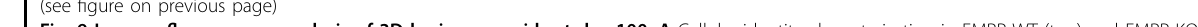
Fig. 9 Immuno fl uorescence analysis of 3D brain organoids at day 100. A Cellular identity characterization in FMRP-WT (top) and FMRP-KO (bottom) brain organoids. Immunostaining at day 100 revealed the presence of cells positive for pan-neuronal marker MAP2 (red) and GFAP expressing astrocytes (green). Nuclei were stained with DAPI (blue). Scale bar: 500 μ m. B Higher magni fi cation of representative GFAP-positive regions within FMRP-WT (top) and FMRP-KO (bottom) brain organoids at day 100. Scale bar: 20 μ m. C Bar charts showing the fl uorescence intensity quanti fi cation of MAP2 signal ( p = 0.9, MW test) and GFAP signals (*** p < 0.001; WT n = 24/4/1, KO n = 32/4/1, slices/organoids/batches). D Scatter plot of astrocyte density in FMRP-WT ( n = 55/6/4/1, FOVs/slices/ organoids/batches) and FMRP-KO brain organoids ( n = 58/5/4/1, FOVs/slices/ organoids/batches) at day 100 ( p =